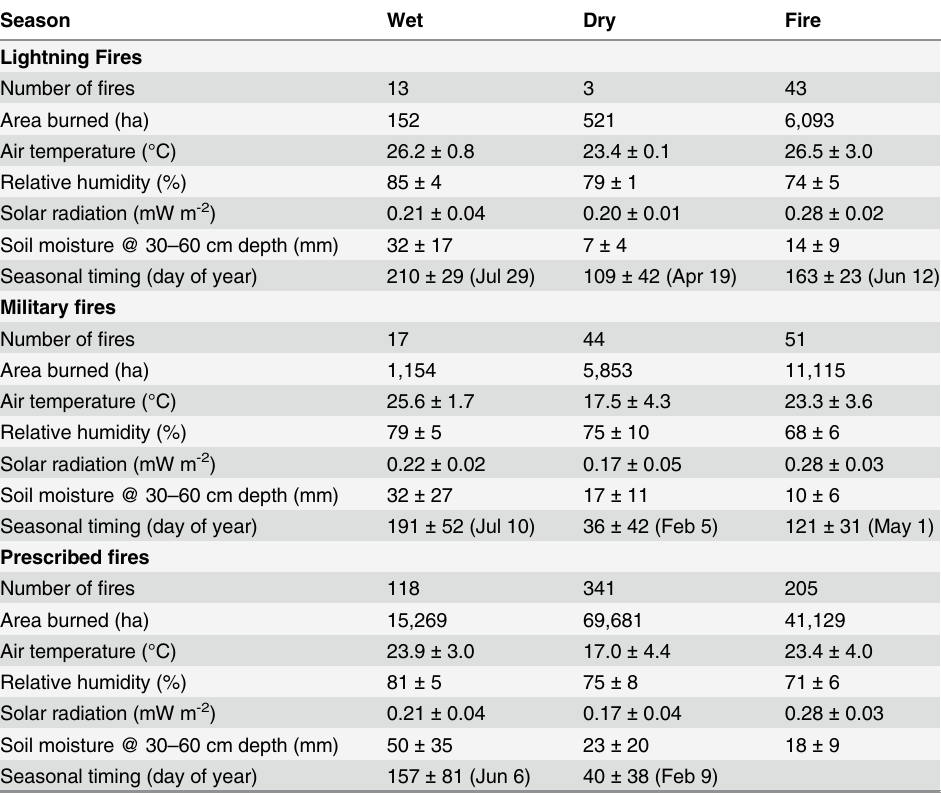
For fi res, data are sums over the period of record. For weather conditions, data are means ± 1 standard deviation. Data are grouped by the three seasons as produced by the representative 3-season model. Values for dry season are adjusted to include days spanning across different